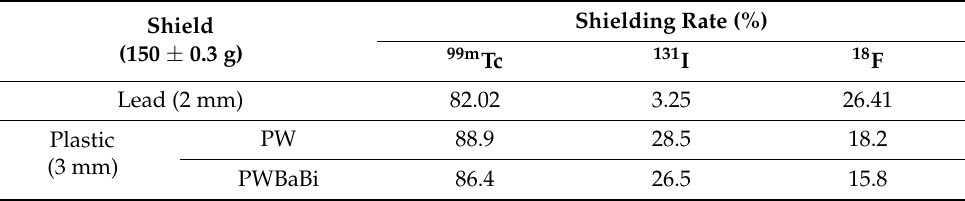
Table 5. Comparison of shielding rate between syringe lead shield and tungsten-based plastic shields (based on a distance of 0.3